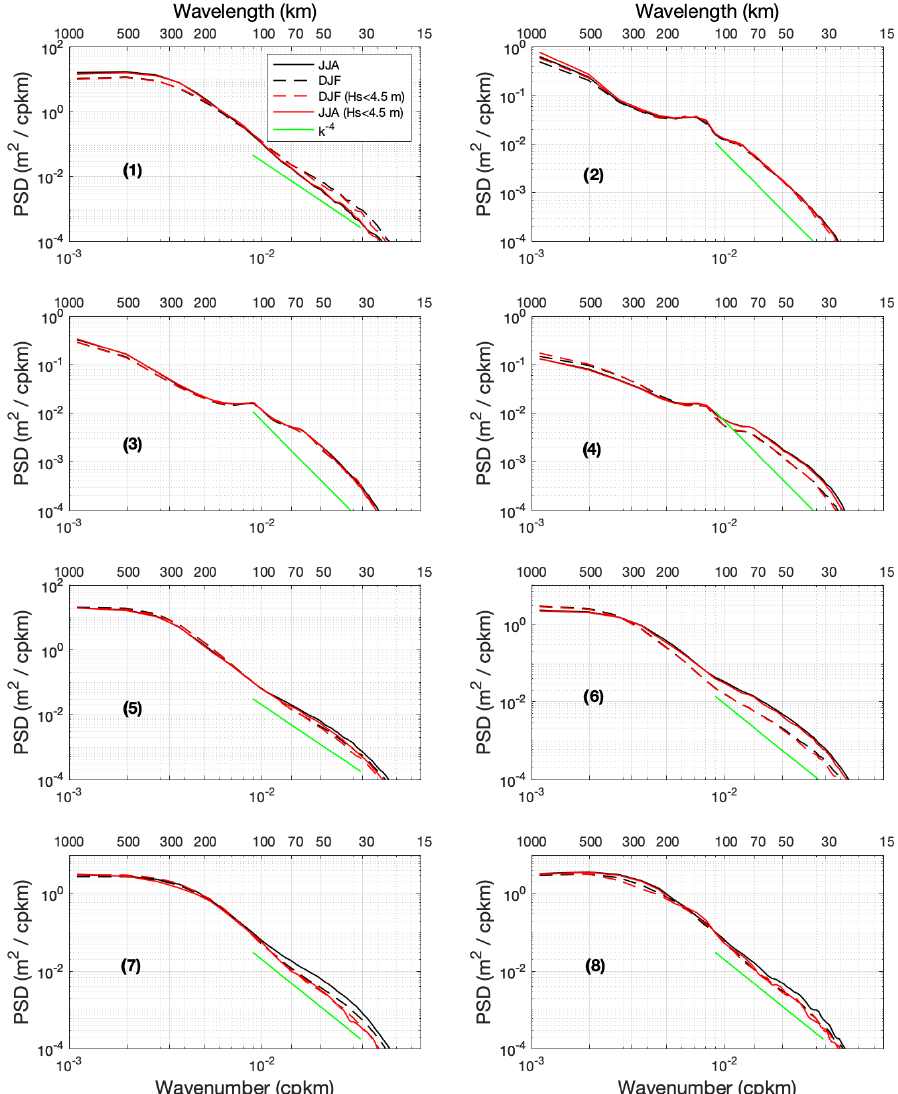
Figure 8. Mean PSD (m 2 per cycles per kilometer) of AltiKa denoised SLA in boreal summer (solid black curve, JJA) and in boreal winter (dashed black curve, DJF). The red curves show the results using a data set limited to segments showing more than 80% of data with SWH < 4.5m. The numbered eight panels correspond to the eight areas shown in Fig. 7. For reference, a PSD law in k − 4 is shown in the wavelength range of 30–120km, green